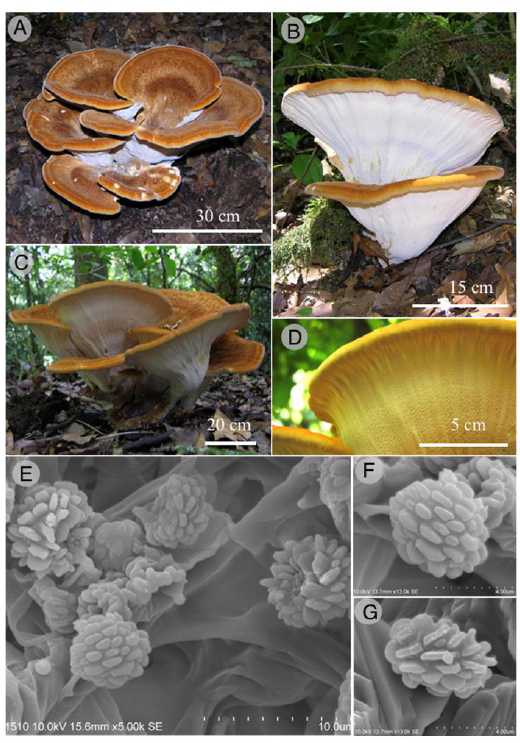
Figure 9. Bondarzewia mesofila . ( A ) : basidiomata; ( B , C ): hymenophore; ( D ): detail of hymenophore; ( E – G ) : SEM of basidiospores.